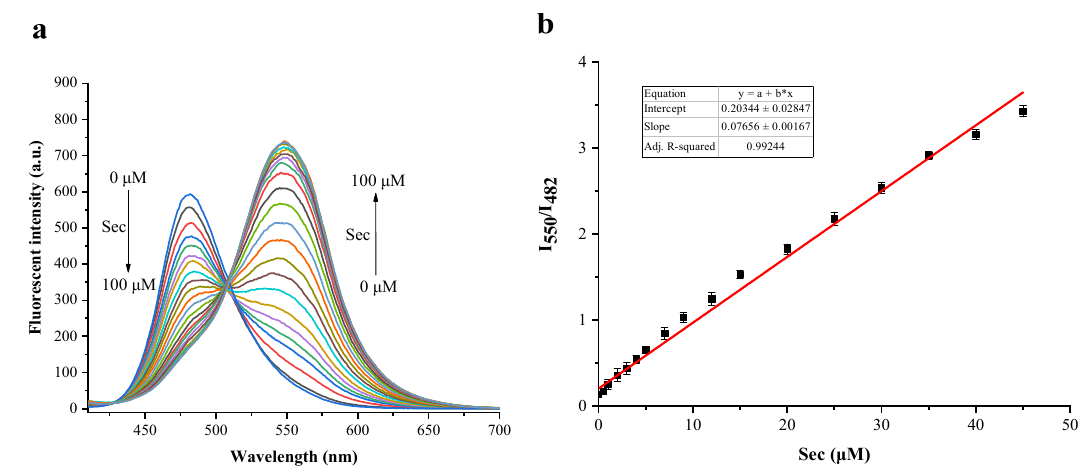
Figure 4. ( a ) Fluorescence intensity variation of 1 μ M Q7 to different Sec concentrations (0, 0.5, 1, 2, 3, 4, 5, 7, 9, 12, 15, 20, 25, 30, 35, 40, 45, 50, 60, 70, 80, 90, 100 μ M). ( b ) The linear relationship of the fluorescent intensity ratios I 550 /I 482 of 1 μ M Q7 and Sec concentrations, excited at 400 nm.